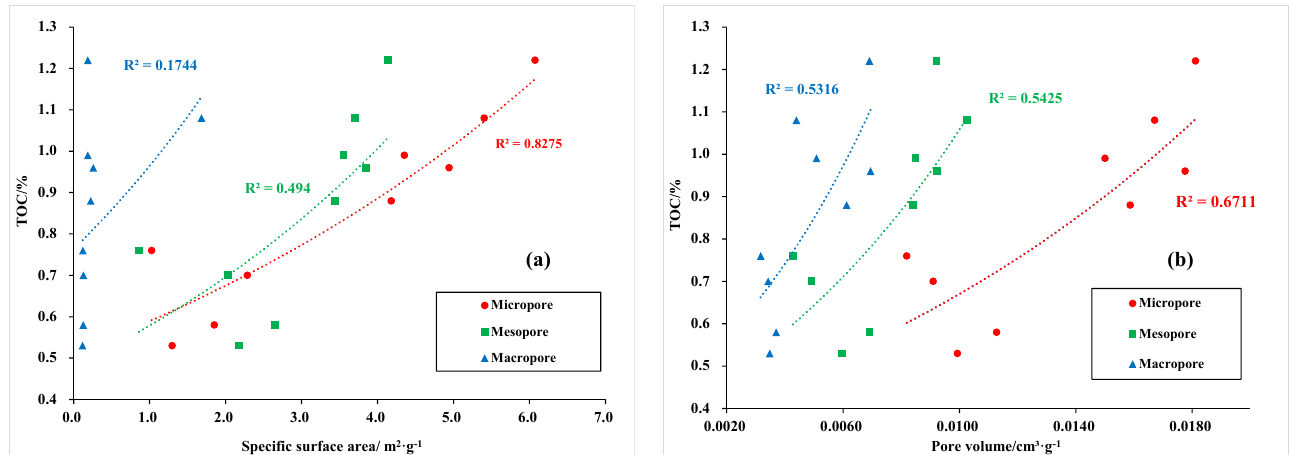
Figure 9. Relationship between pore-specific surface area, pore volume and TOC of Dawuba Formation shale in the Qianxi area. ( a ) Relationship between pore-specific surface area and TOC; ( b ) Relationship between pore volume and TOC.